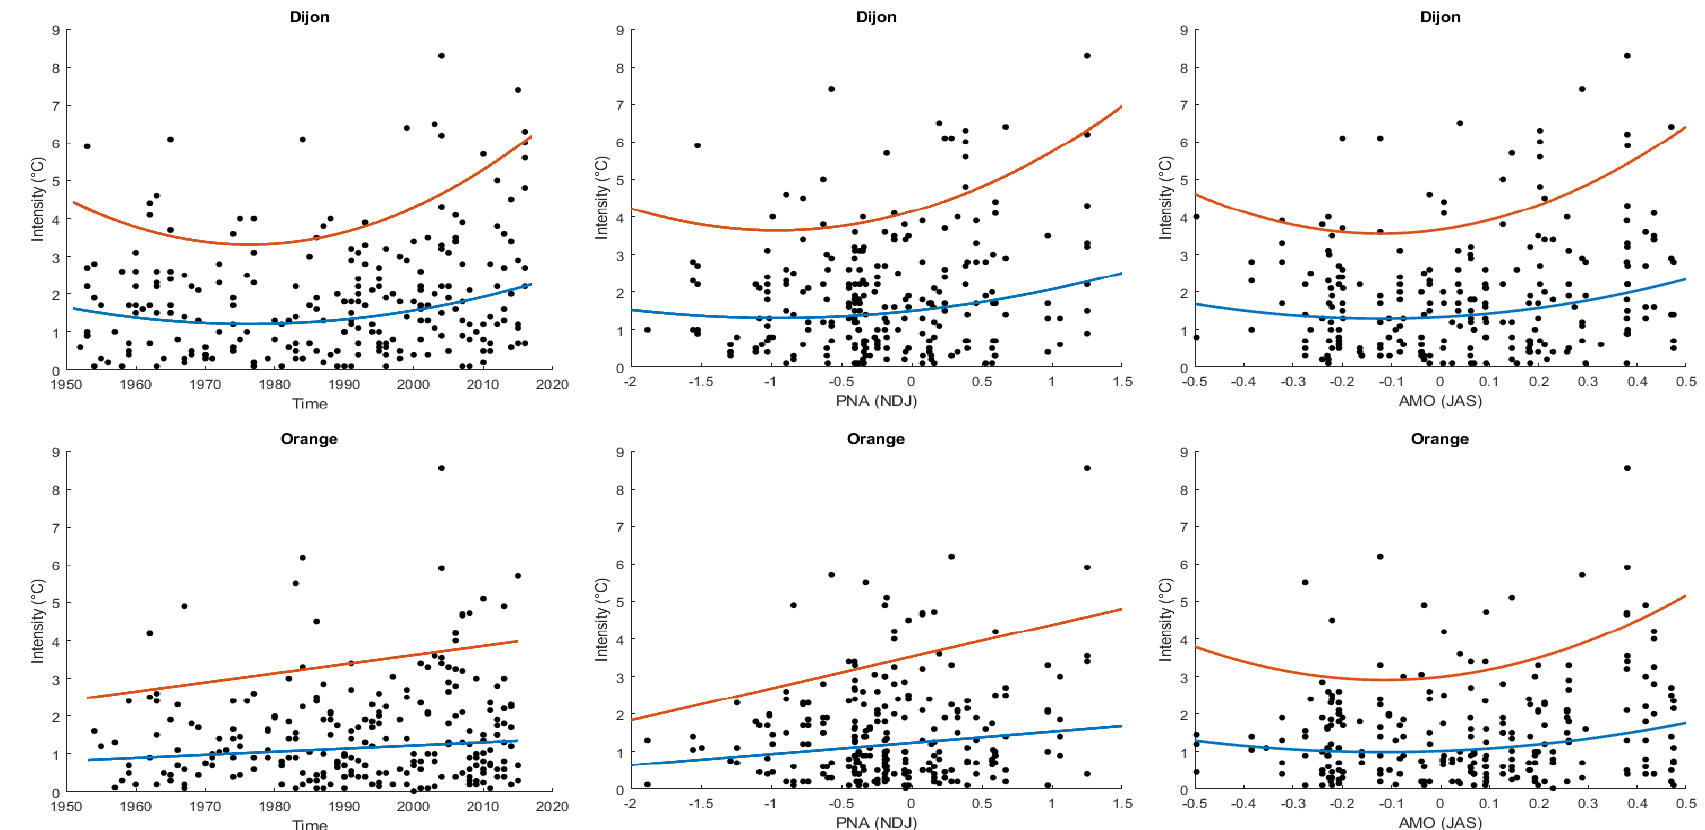
Figure 7. Intensity quantiles corresponding to the non-exceedance probabilities p = 0.5 (blue line) and 0.9 (red line) as a function of each covariate.